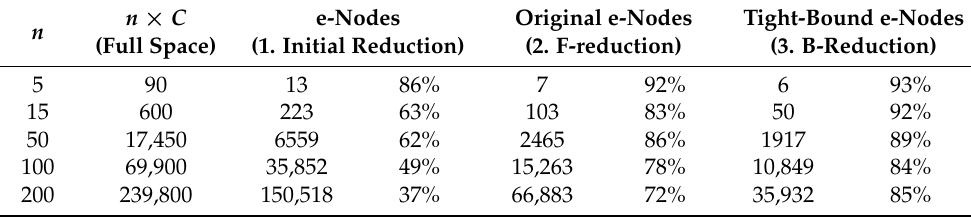
Table 4. Performance (percentage) of space reduction by the DPT-List TSR ( n ≤ 3000). n × C e-Nodes Original e-Nodes n (Full Space) (1. Initial Reduction) (2.